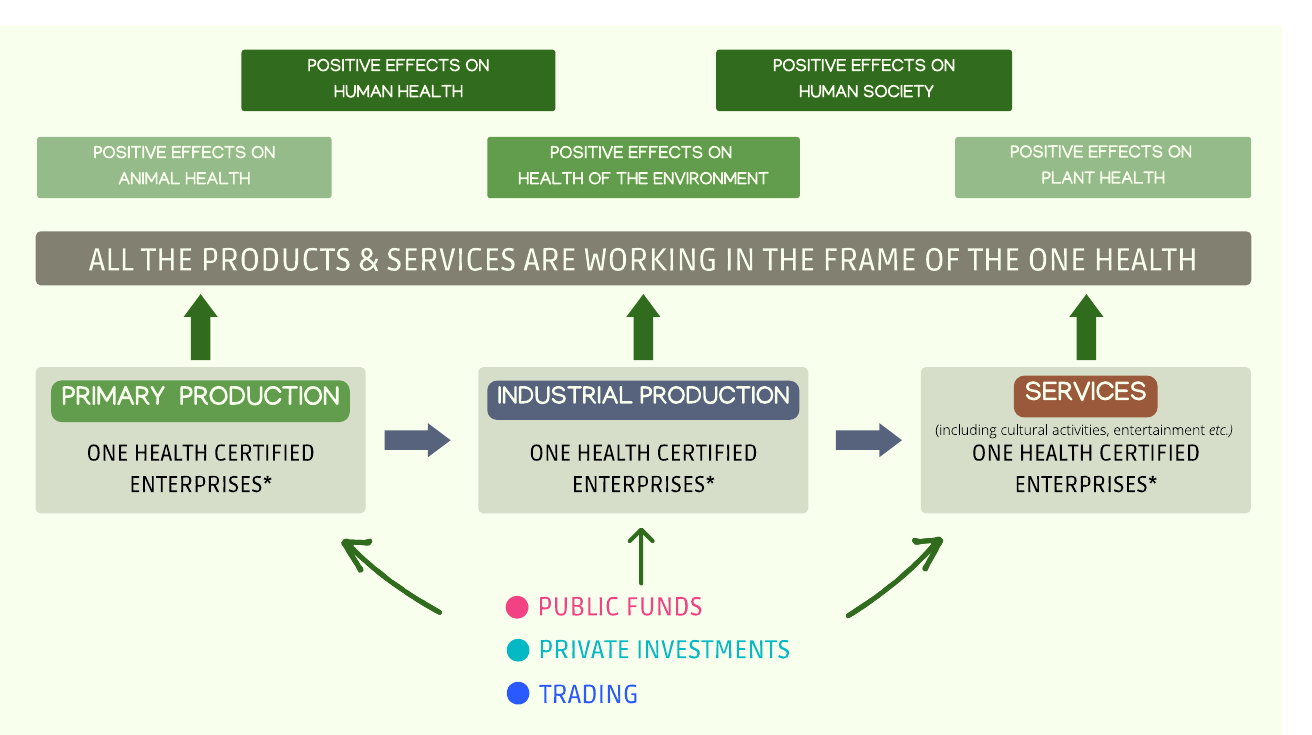
Figure 2. The in-embryo One Health Financial Model.